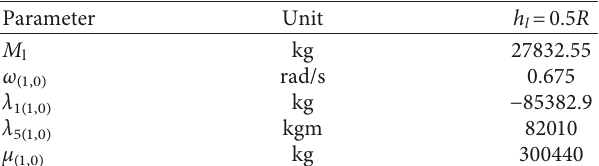
Table 4: Hydrodynamic coefficients.